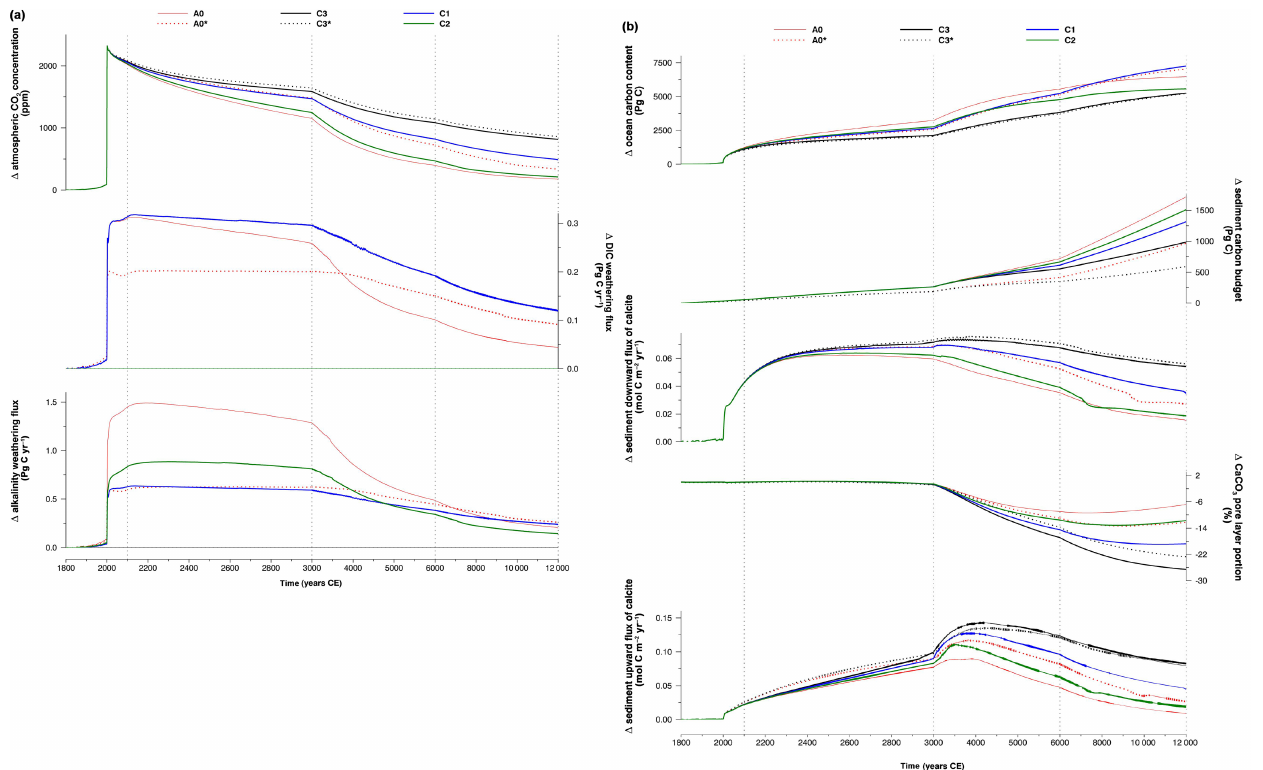
Figure 8. Time series of simulated changes in various model outputs for Group C scenarios, compared with pre-industrial steady-state values. These scenarios include A0 (both weathering types active), C1 (carbonate weathering only), C2 (silicate weathering only), and C3 (no weathering), as well as the zero-dimensional counterparts to C0 and C3 (indicated by the “ ∗ ” symbol). Shown here are (from top to bottom) (a) atmospheric CO 2 concentrations, and weathering fluxes of DIC and alkalinity; and (b) oceanic carbon difference, sediment carbon difference, downward flux of calcite into sediments, calcite pore layer portion, and dissolution of calcite in sediments. Note the different scales along the time axis, which change at years 3000 and 6000. Vertical dashed lines are used to indicate times for which results are shown in Figs. 4, 5, and 7. The curves shown here represent experiments A0 (red), C1 (blue), C2 (green), and C3 (black), with dashed colored lines representing the zero-dimensional equivalent model version (when